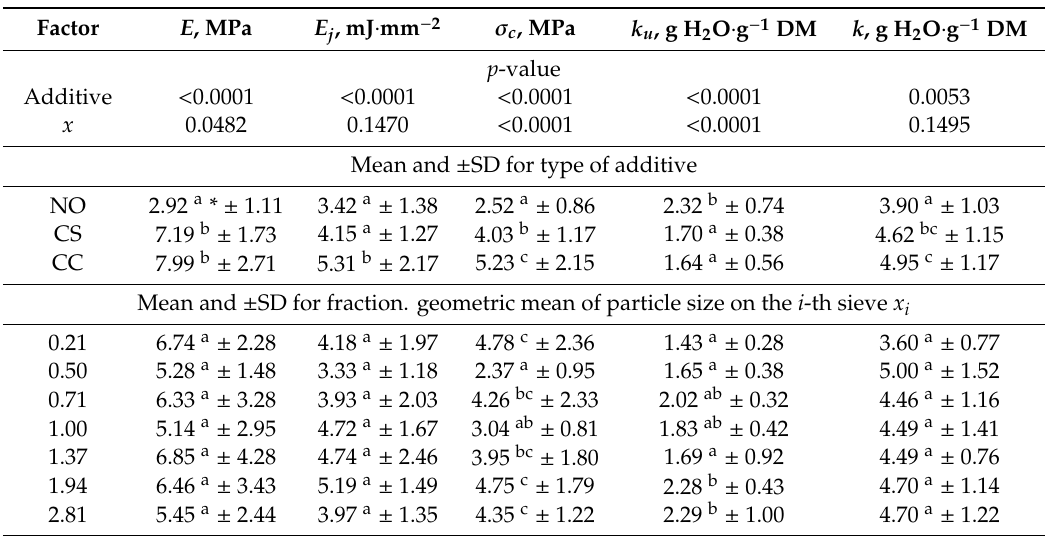
Table 2. Results of variance analyses, mean values (with three repetitions for each measurement setup), and SDs of the elasticity modulus for pellet compression, DM-specific pellet compression work, DM-specific work for pellet shift in die, tensile strength pellet compression, water absorption by uncrushed pellets, and water absorption by crushed pellets for di ff erent type of additive and fraction particle size ( x